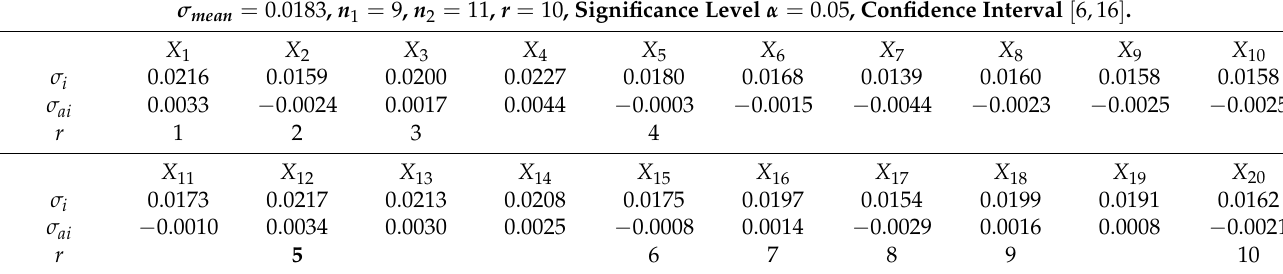
Table 4. Run test process of z -axis BiLSTM network